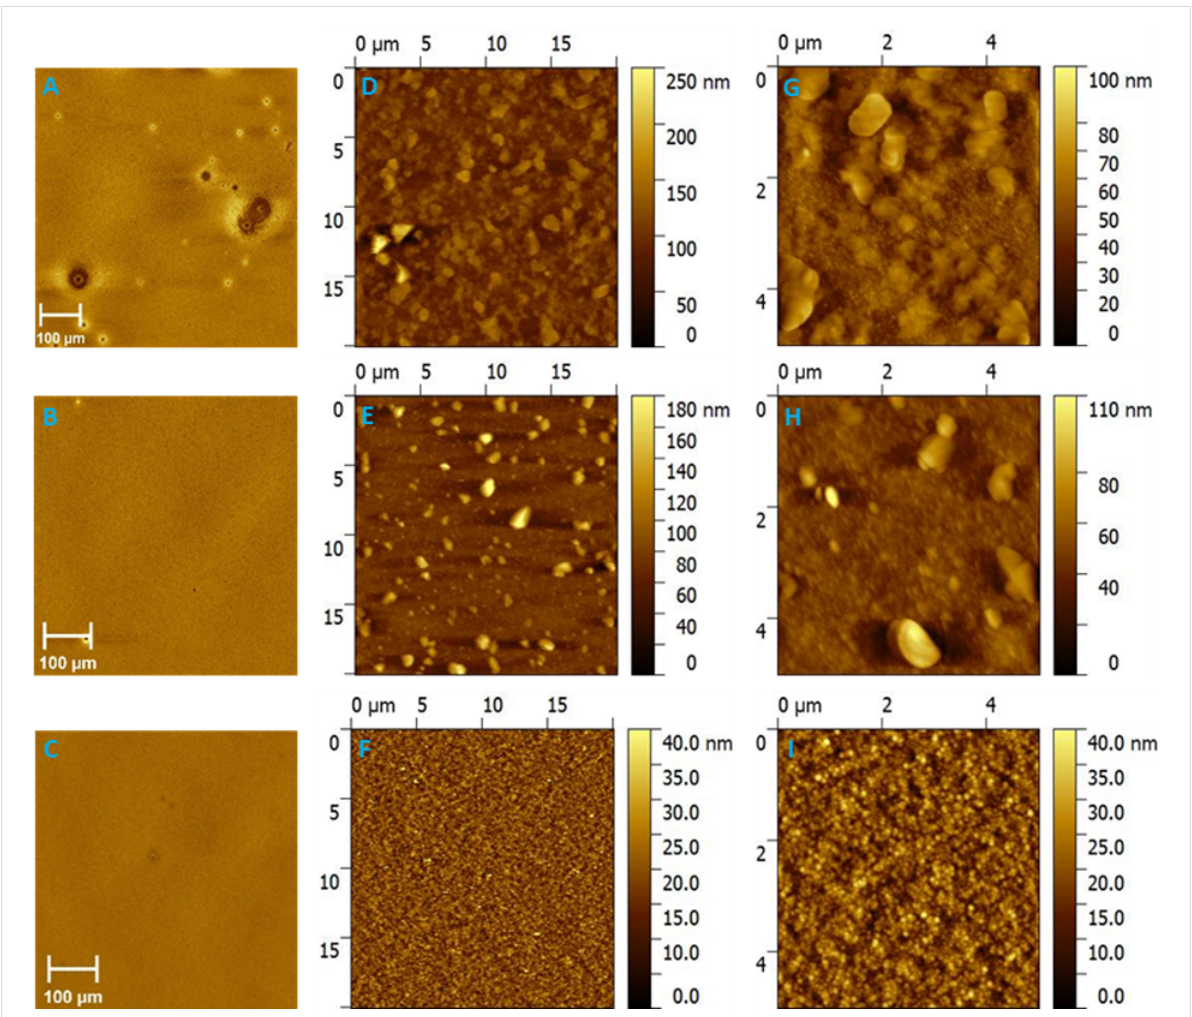
Figure 3: Optical microscopy (A–C), scale bar 100 µm, AFM images with scale bar 20 × 20 µm (D–F) and 5 × 5 µm (G–I) of P3HT:ICxA NP films with dilution factors 625 (A,D,G), 7.8 × 10 4 (B,E,H) and 9.8 × 10 6 (C,F,I) for centrifugal ultrafiltration.